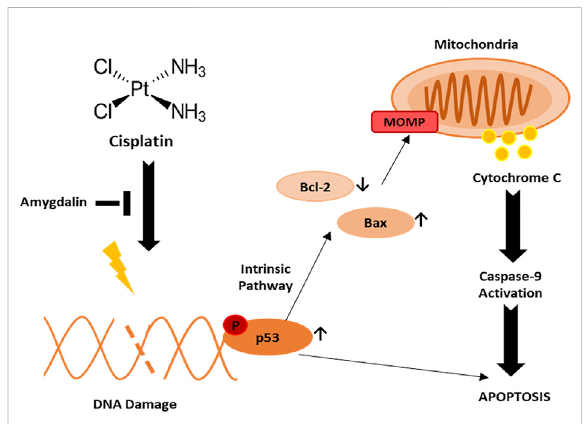
FIGURE 6 Potential mechanism of action of amygdalin and cisplatin in normal breast cell against breast cancer. Uponcisplatintreatment, DNA damage is induced followed by activation of phospho-p53 leading to apoptosis. Phospho-p53 may induce apoptosis through downregulation of Bcl-2 and upregulation of Bax leading to MOMP and activation of